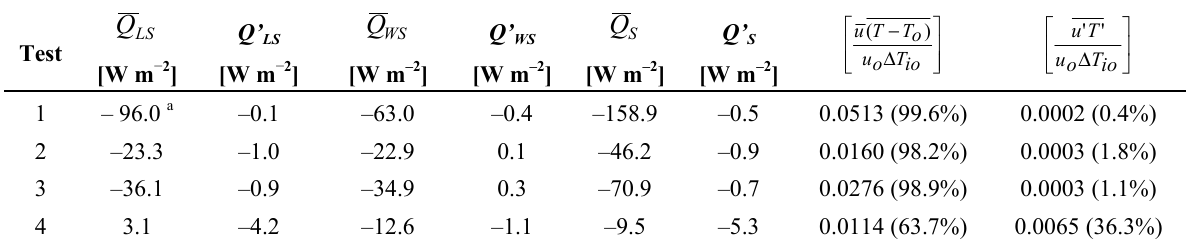
, the mean Q and turbulent Q’ sensible heat fluxes Table 3. Values of outside radiation R g by greenhouse surface for the windward (WS) and leeward side vents (LS), and the average mean and turbulent sensible heat exchanges (two bracketed